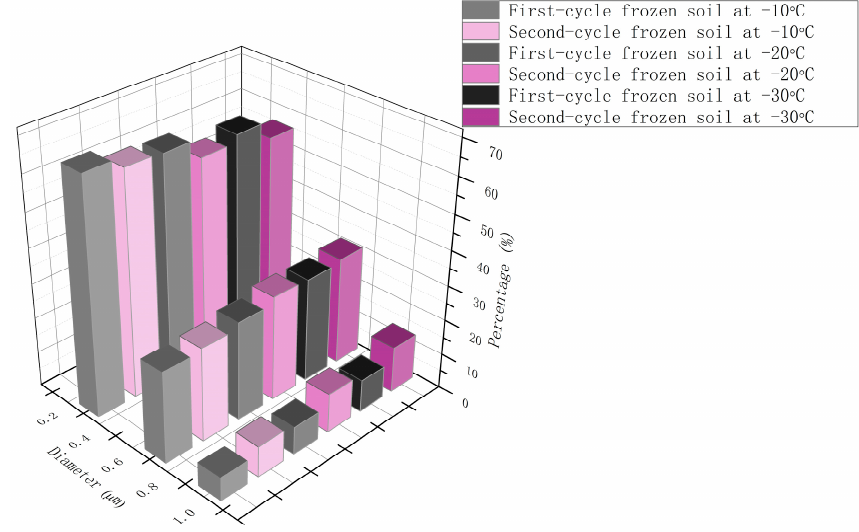
Figure 13. Distribution of the diameter under the second freeze–thaw cycle.